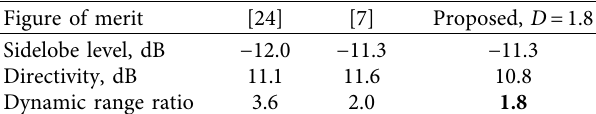
Figure 7: Distribution of all-positive (blue) as well as positive-and- negative (red) coefcients in pencil beam arrays with various numbers of elements and beamwidth of 12 ° , obtained by mini- mization of SLP and constrained DRR. Black curve indicates maximum DRR, which is achieved in DRR-unconstrained design. Table 2: Properties of proposed pencil beam array with 16 elements and beamwidth of 10 ° , compared with array having equiripple sidelobes and unconstrained DRR [24] and with array having minimum DRR for given SLL and all positive coefcients [7]. Improvement is highlighted in bold.